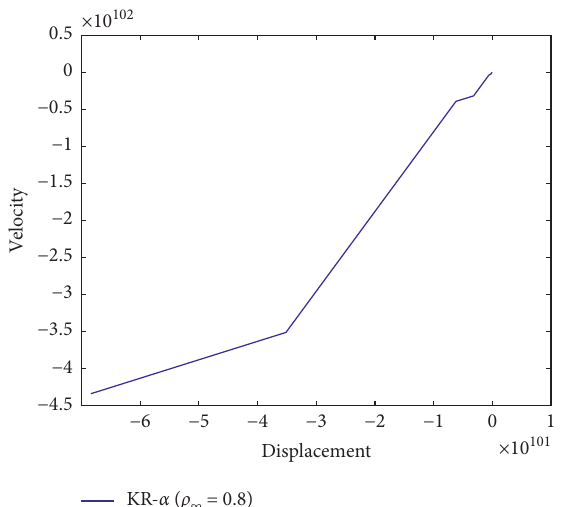
Figure 28: Phase portrait of the hardening spring calculated using the KR-method ( ρ